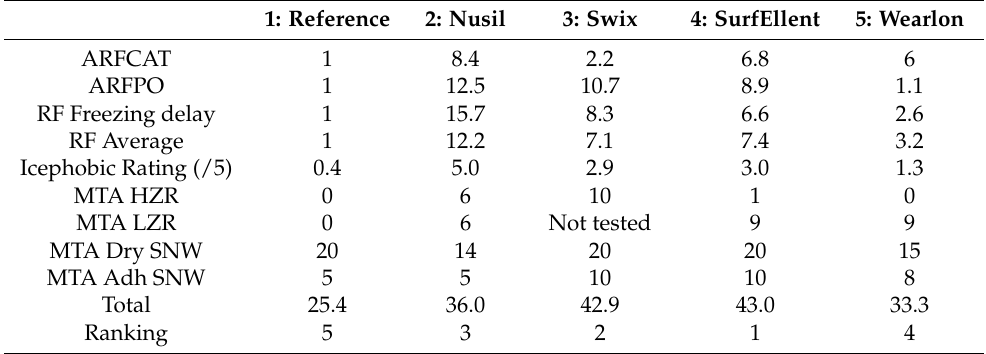
Table 4. Ranking of tested